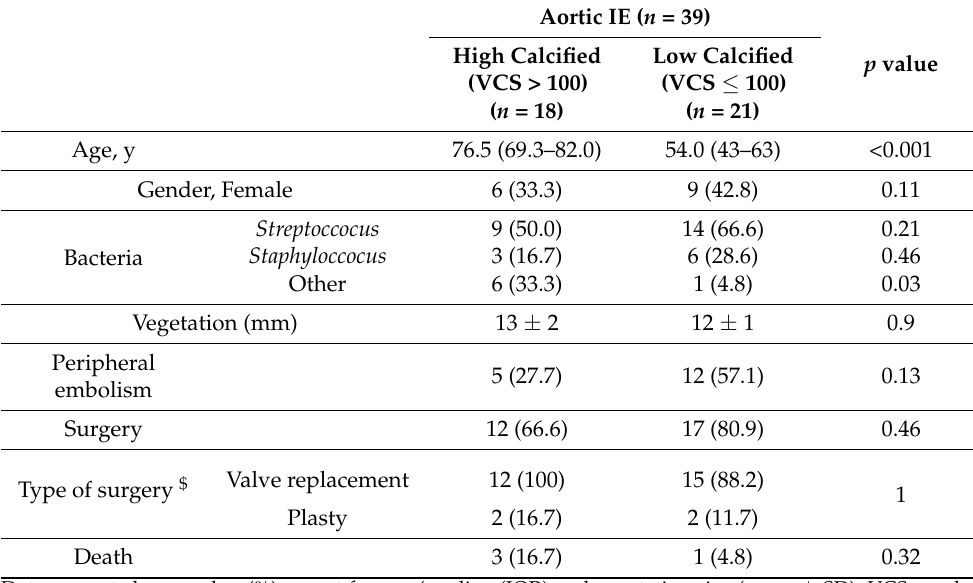
Table 3. Characteristics of patients with native aortic IE in function of aortic valvular calcium score